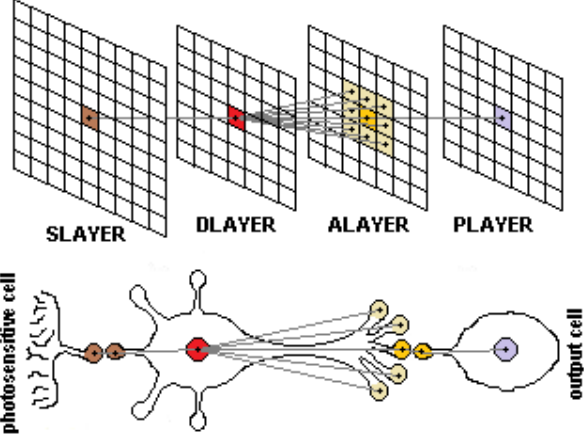
Figure 2. ( Top ) Interrelation between layers created in the LDSI algorithm. Lines between layers show the interconnections and data flow from the events generated in the input sensory layer ( Slayer ) corresponding to an event-based sensor (DVS camera in this case) to the output layer Player with filtered data. ( Bottom ) Equivalence of the proposed layer model in the LDSI algorithm with a biological neuron.